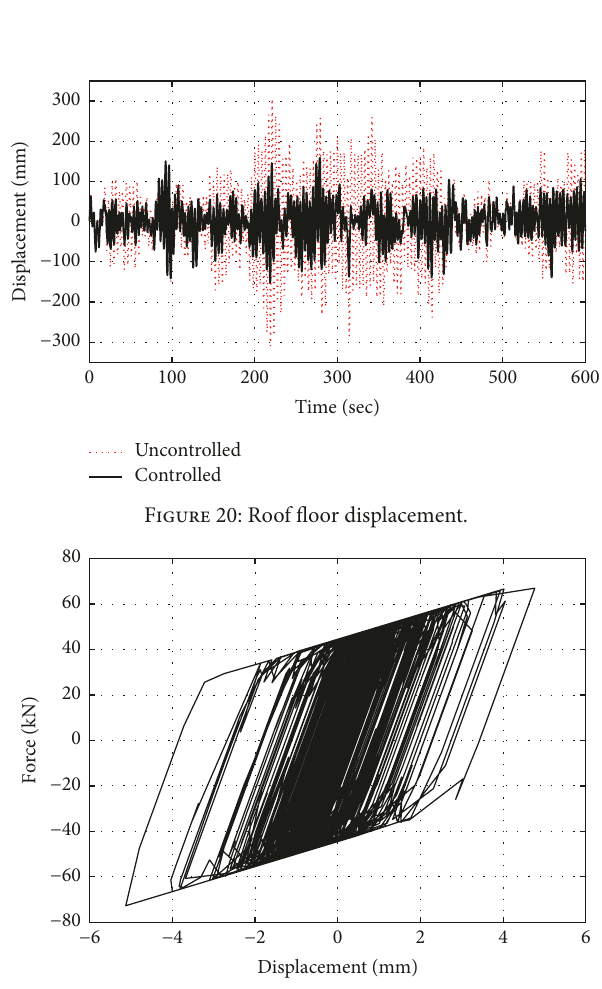
Figure 21: Hysteretic curve of a MHD installed at the first floor.